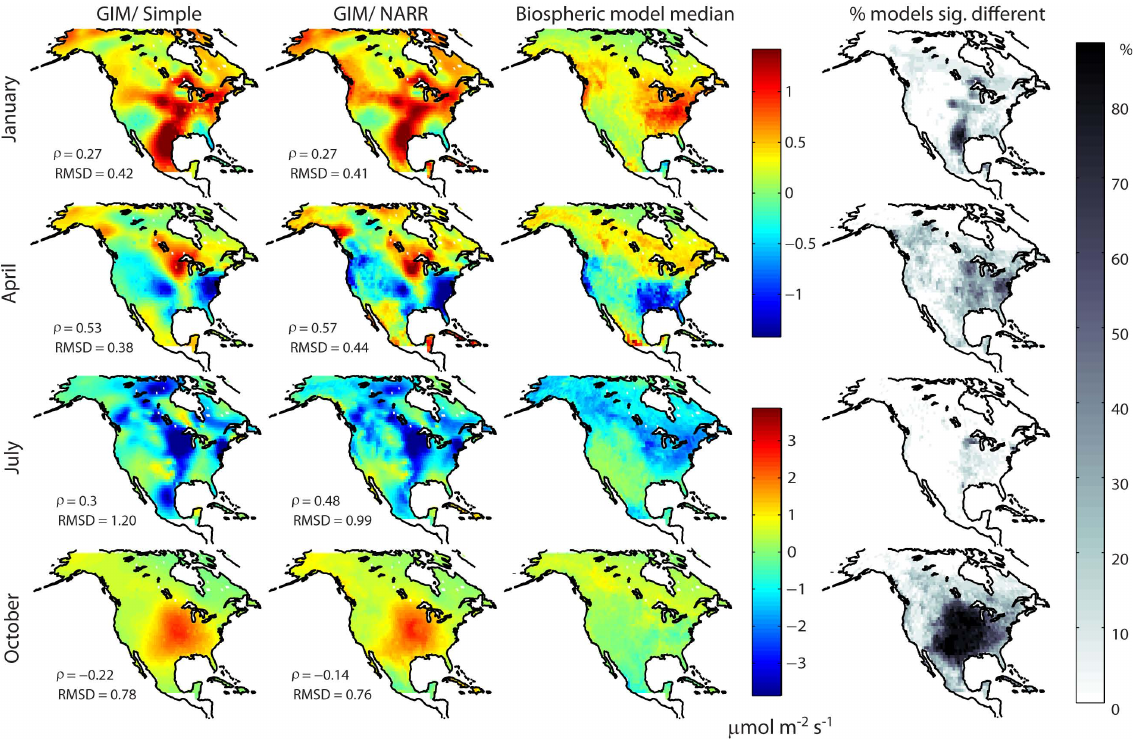
Fig. 4. Monthly-averaged grid-scale biospheric fluxes for January, April, July and October from the Simple and NARR inversions using the EMP boundary conditions, and the median of biospheric models participating in the NACP RCIS. Also shown are the grid-scale spatial correlation coefficients ( ρ ) and Root Mean Squared Difference (RMSD; µmol m − 2 s − 1 ) between the inversion and the biospheric model median fluxes. Please note the different scales for each month. The plots in the right-most column show the percent of individual biospheric models that are outside the 95% confidence intervals of the NARR inversion for each month and location. areas with a large consumption of agricultural products